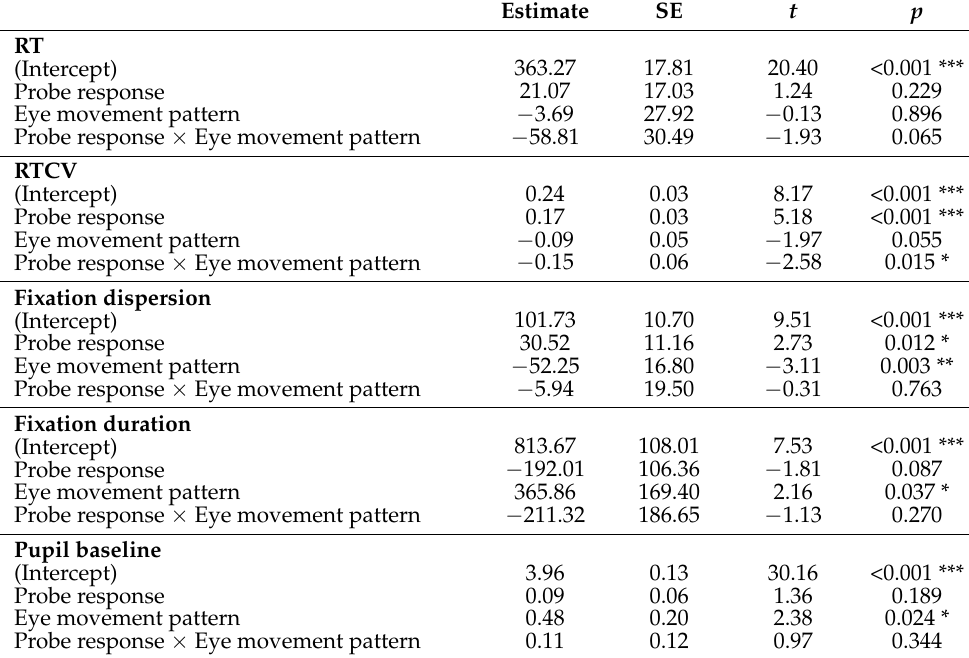
Figure A1. Behavioral performance and eye movement indices in the pre-target intervals. ( A ) Reaction time (RT). ( B ) Coefficient of variance of RT (RTCV). ( C ) Fixation dispersion. ( D ) Fixation duration. ( E ) Pupil baseline. The number in the bar graph denotes the mean value in that condition. Error bars represent one S.E.M. Table A2. Behavioral response data and eye movement data for the 10-s pre-probe period (the subjective measurement of MW) analyzed with LMM.